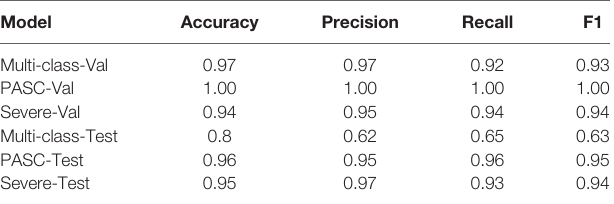
TABLE 2 | Random forest classi fi er predictor performances on the validation and test